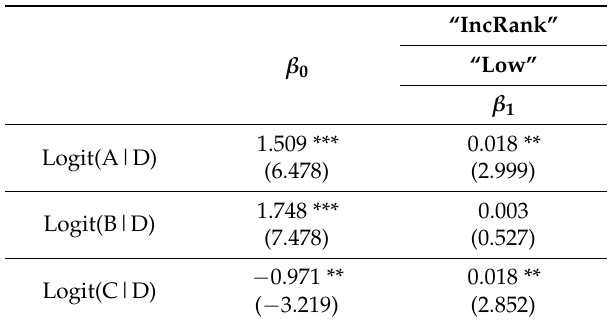
Table 15. Estimation results of “End” against “Income”.